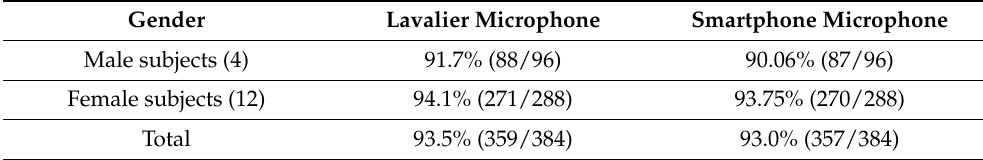
Table 15. Speech recognition